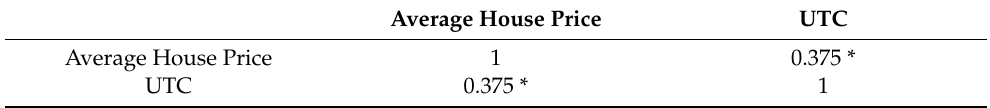
Table 6. Pearson correlation coefficient table.